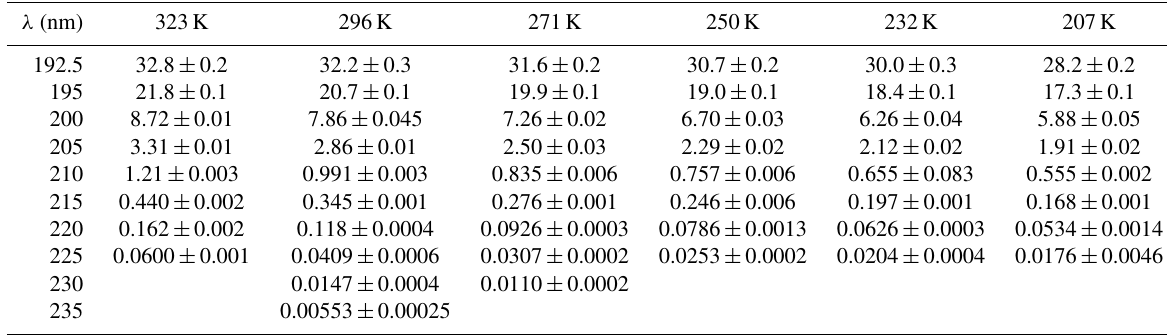
Table 2. CCl 2 FCF 3 (CFC-114a) UV absorption cross section data (10 − 20 cm 2 molecule − 1 , base e) obtained in this